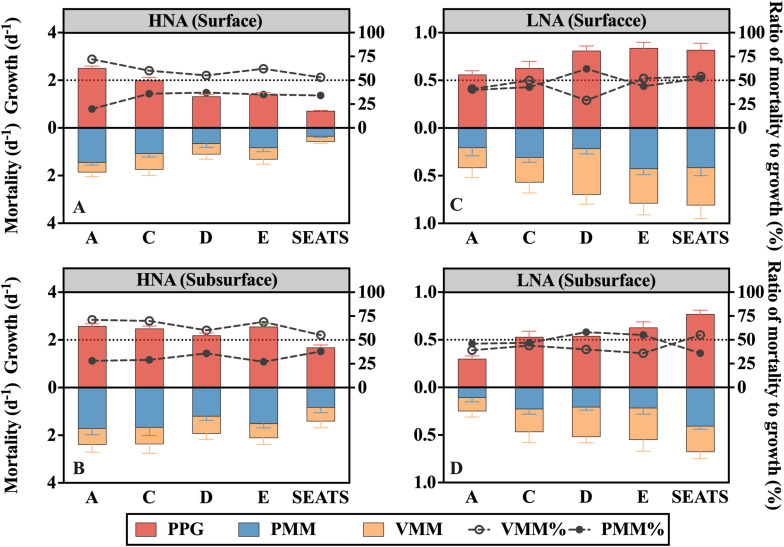
Potential prokaryotic growth rate (PPG), mortality rate mediated by protozoan grazing (PMM) and viral lysis (VMM), and ratios of PMM (PMM%, filled dots) or VMM (VMM%, empty dots) to PPG for the (A,B) HNA subgroup and (C,D) LNA subgroup at stations along the transect at the surface and subsurface layers. The horizontal dashed line denotes the ratio of 50%.